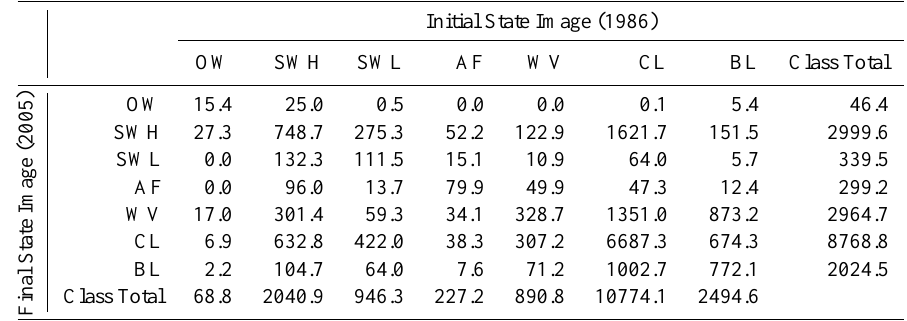
Table 5. Change detection statistics.